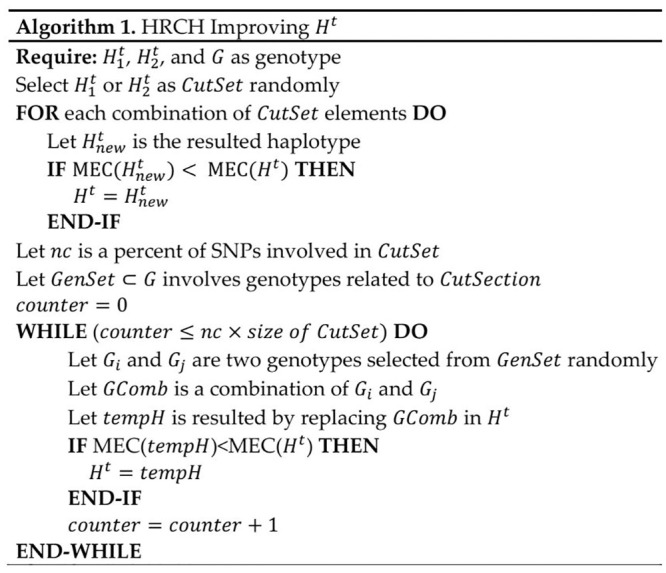
The algorithm of improving Ht.